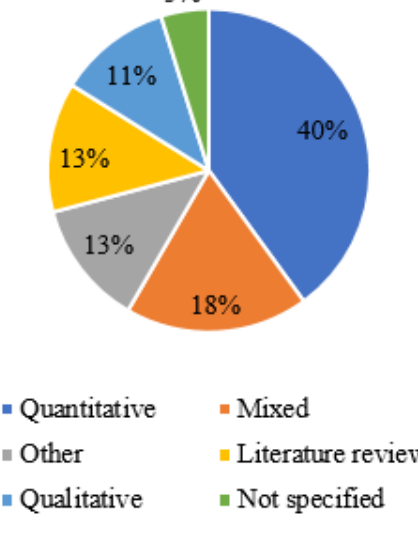
Figure 1 . Distribution of studies by